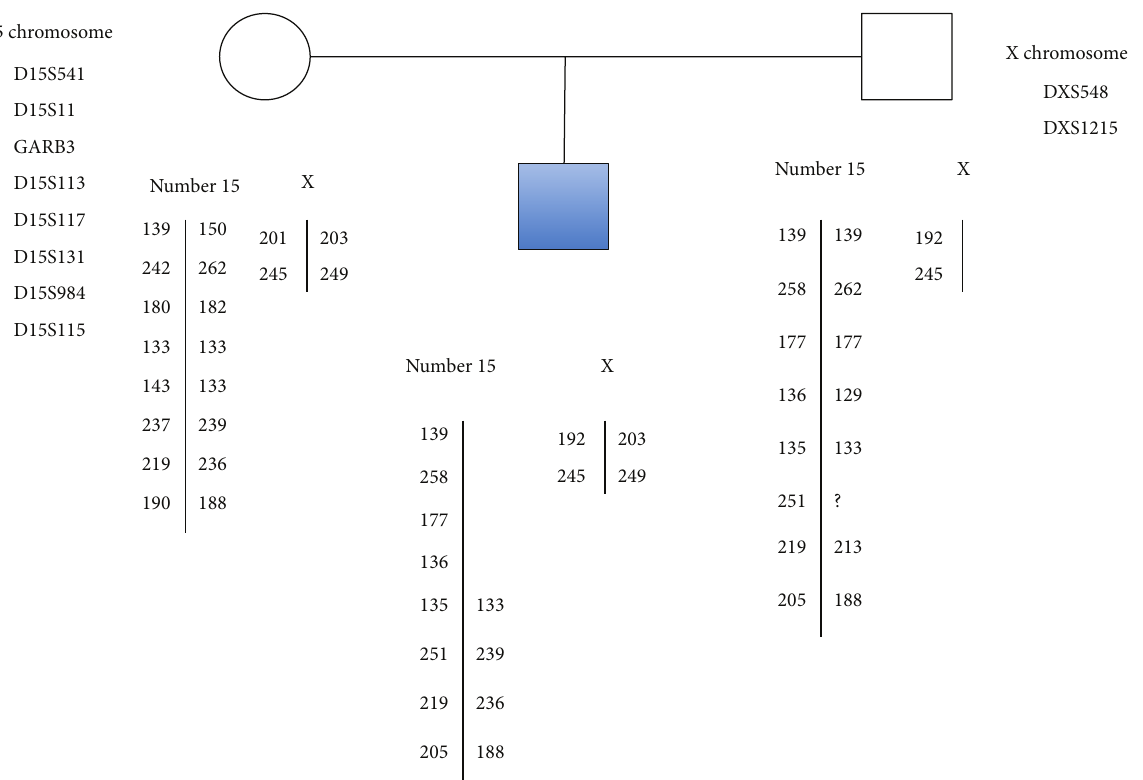
Figure 4: Microsatellite analysis and pedigree of the family. Microsatellite from X chromosome showed one of paternal origin and other of maternal origin. Microsatellite from 15 chromosome showed a deletion of D15S541, D15S11, GARB3, and D15S113 of maternal